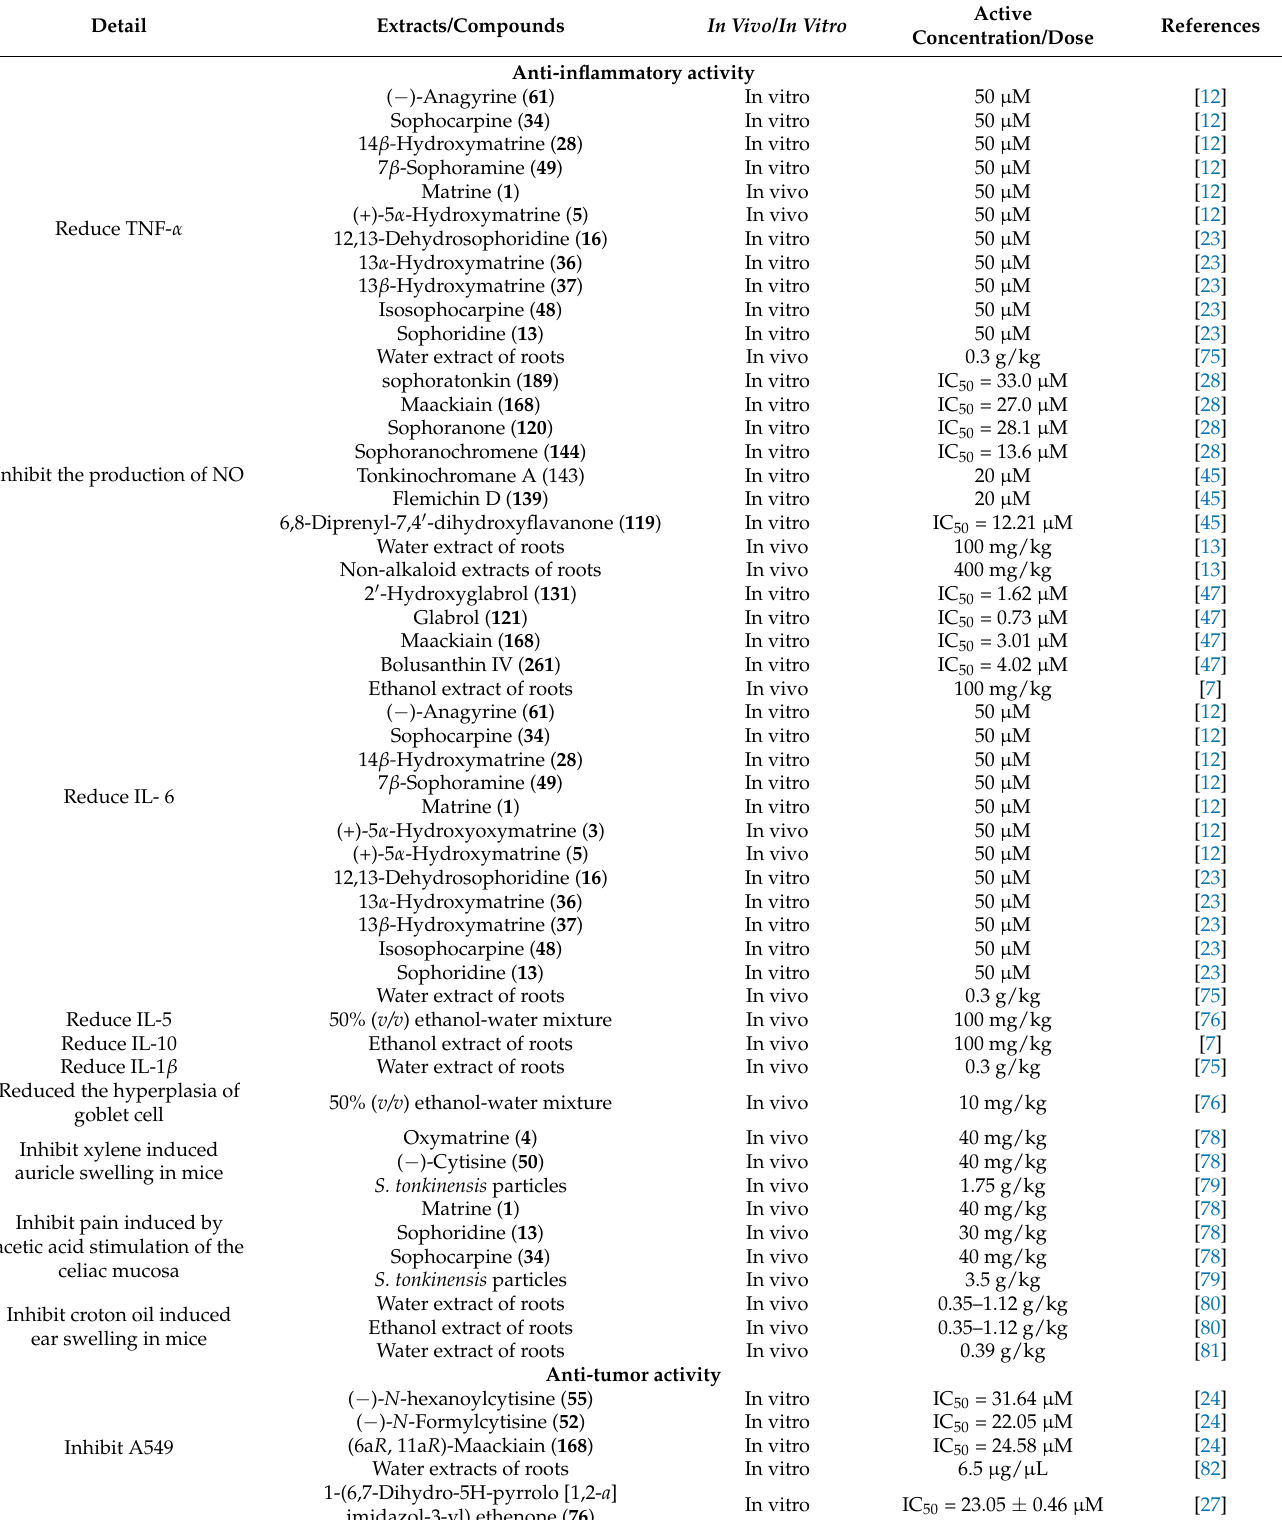
Table 2. The comprehensive list of the pharmacological activities from S. tonkinensis